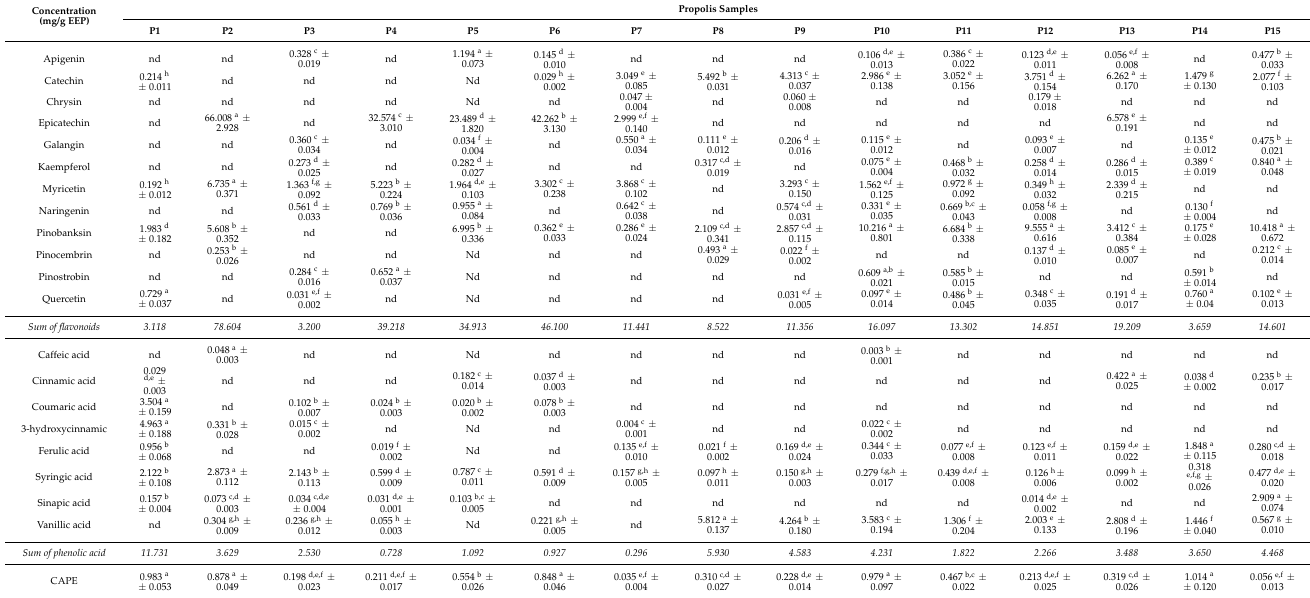
Table 1. The concentration of phenolic compounds in propolis